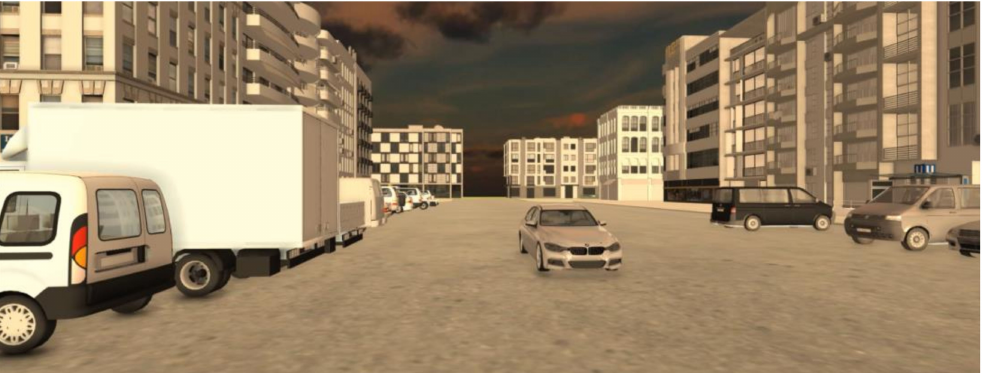
Figure 3. Virtual reality